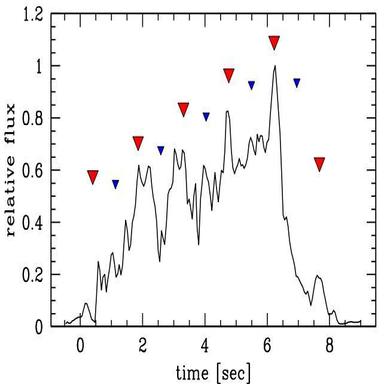
The apparent luminosity of WT1190F during its atmosphere burning phase, according to the observations. At the timeline origin of the plot, the object started to brighten at a height of 73 km reaching a maximum peak luminosity 6.3 s later, about 50:5 2:5 km. Notice the flashing behaviour along the atmosphere entry, which seems to be consistent with Eq. (primary and secondary peaks, as from are sketched respectively by red and blue triangles along the curve). (For inter